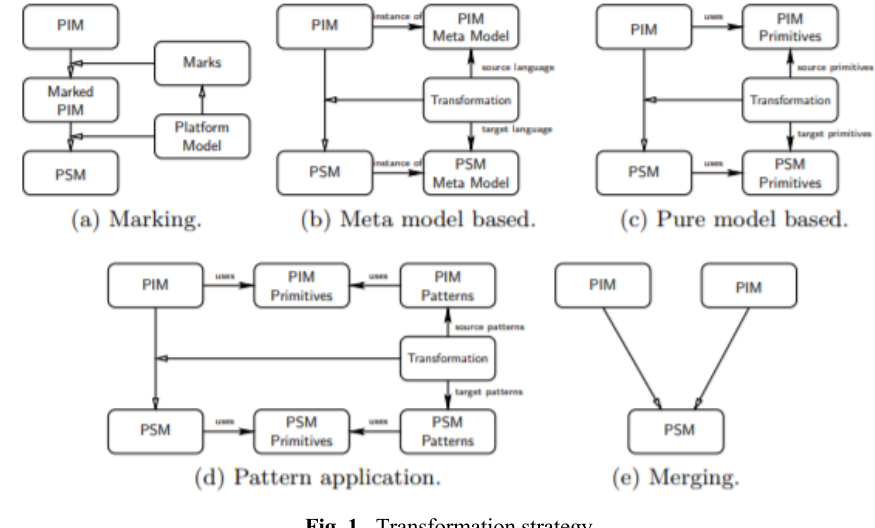
Fig. 1. Transformation